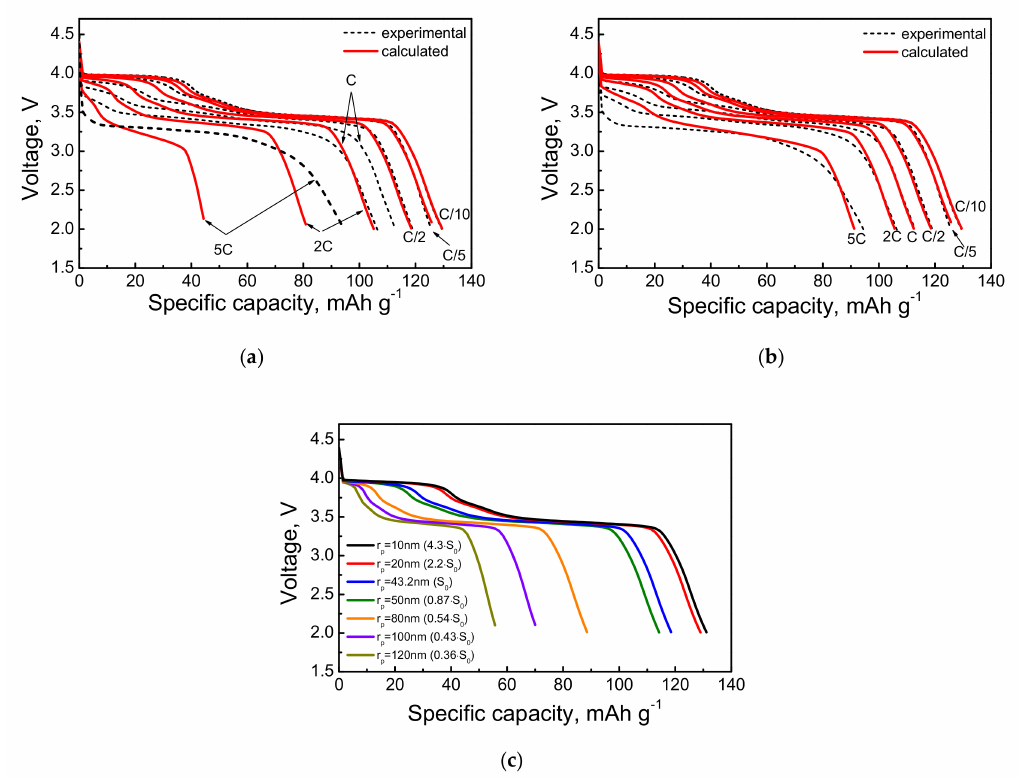
Figure 7. Comparison of calculated and experimental curves of LFMP / C with a constant coe ffi cient of solid-state di ff usion ( a ) and taking into account the temperature dependence of the di ff usion coe ffi cient ( b ); calculated discharge curves at 0.5C current for di ff erent values of the specific surface area and associated values of particle radii, where S 0 is the value of 32 m 2 · cm − 3 measured for the active cathode material ( c